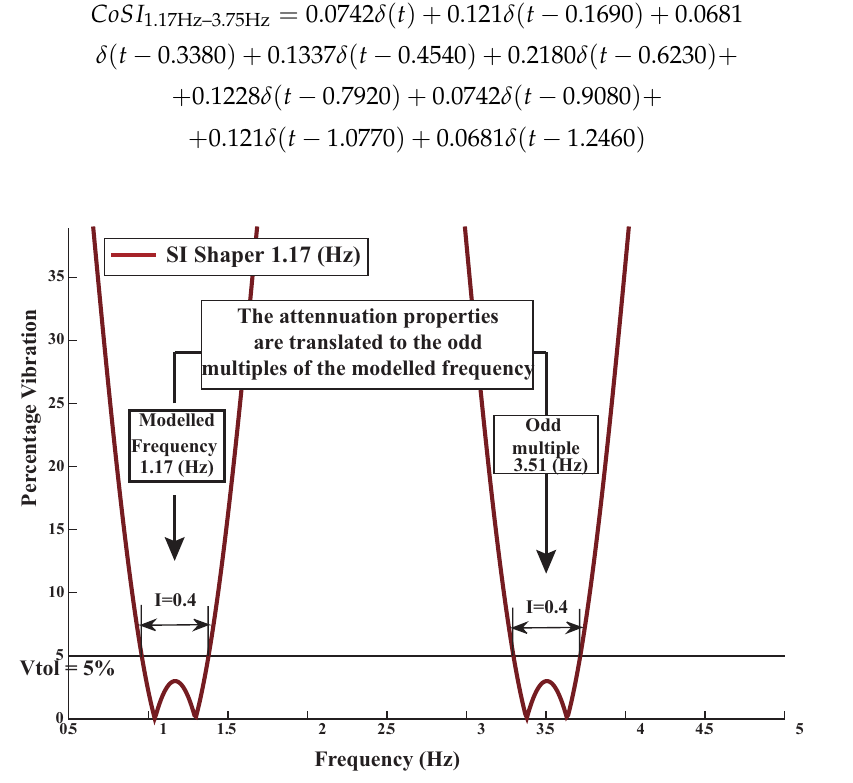
Figure 20. SI Shaper 1.17 Hz sensitivity